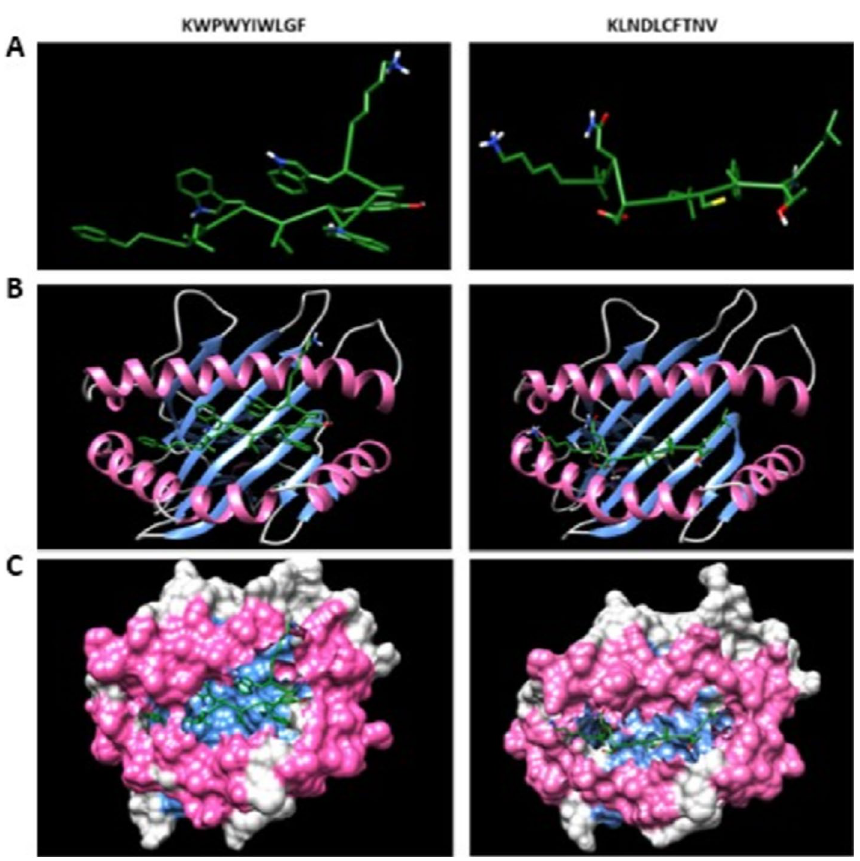
Figure 1. ( A ) Predicted KWPWYIWLGF and KLNDLCFTNV epitopes docking to MHC-I alleles. ( B ) Docking results of epitopes with α chain of MHC-I alleles using ClusPro. ( C ) The snapshot representing the epitope docked in the pocket of molecular surface of the receptor (all the structures are visualised using Chimera